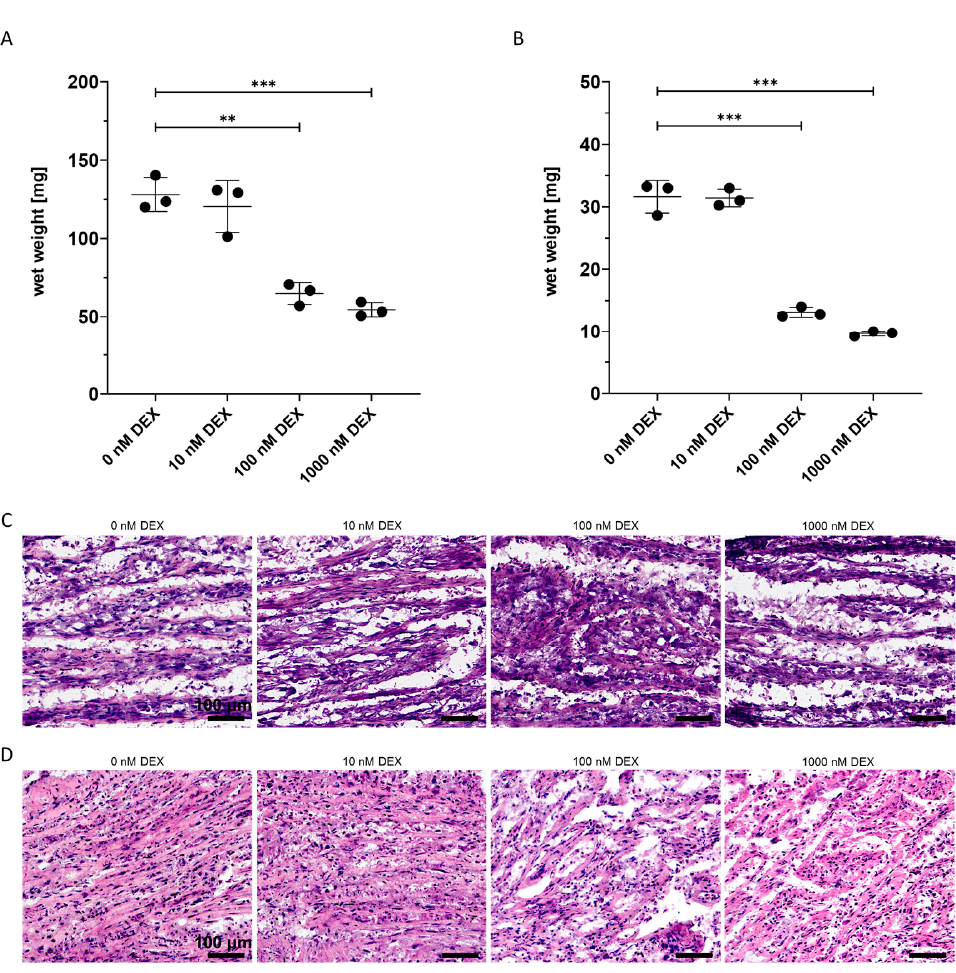
Figure 3. Investigation of wet weight and general morphology of NHDF organoids. ( A ) Wet weight right after organoid formation, d0. ( B ) Wet weight at the end of the 3D maturation process, d14. Lines show mean values ± SD for n = 3 donors and each dot indicates individual donor; ** p < 0.01, *** p < 0.001. ( C ) Representative images of H&E-stained sections of NHDF organoids at d1 of 3D maturation. ( D ) Representative images of H&E-stained sections of NHDF organoids at d14 of 3D maturation.